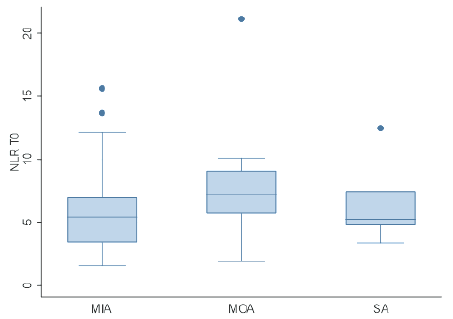
Figure 3. Distribution of NLR within the hypoalbuminemia classes at T0. The NLR is on the Y axis, whereas the hypoalbuminemia classes (MIA = mild hypoalbuminemia, MOA = moderate hypoalbuminemia and SA = severe hypoalbuminemia) are on the X axis.